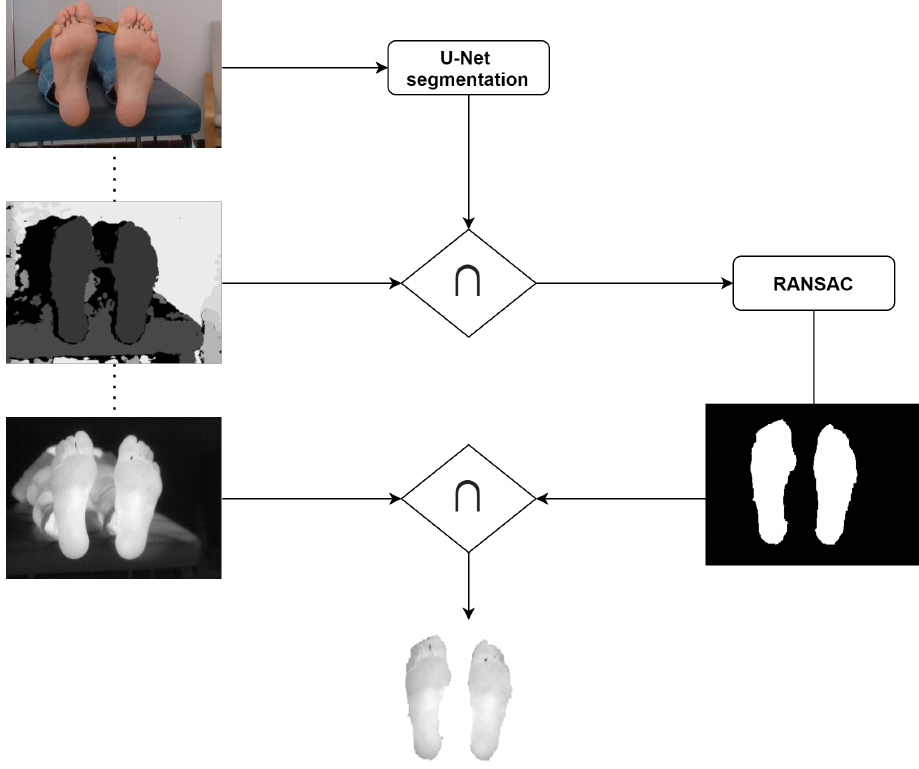
Figure 1. Simplified workflow for the U-Net + Depth (UPD) approach for IR image